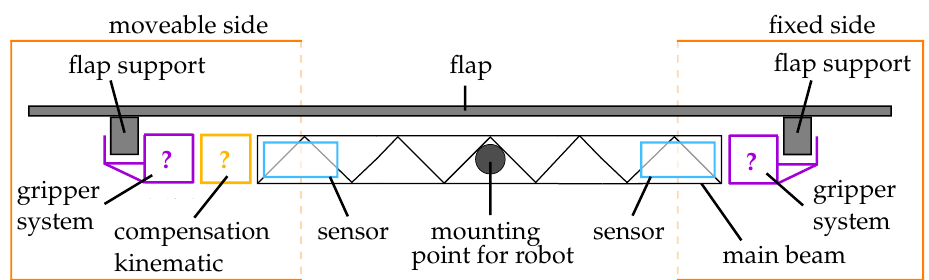
Figure 6. Concept of an end effector for the handling of flap modules